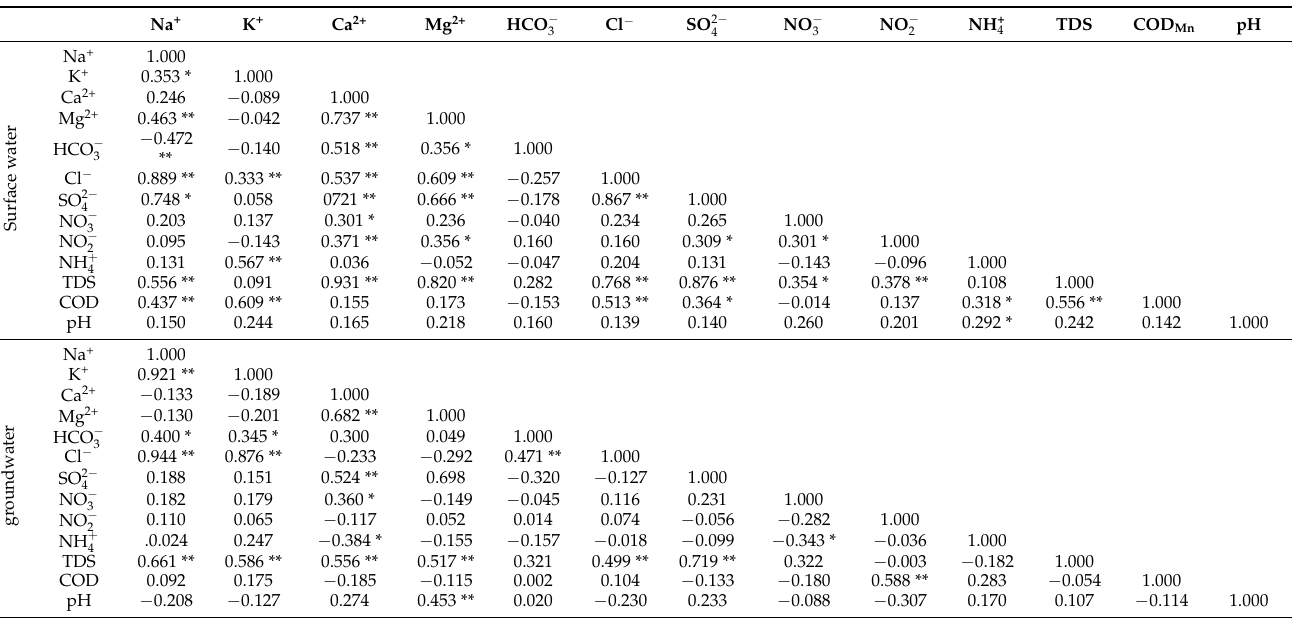
Table 3. Correlation coefficient matrix of water chemistry parameters in NKWS.